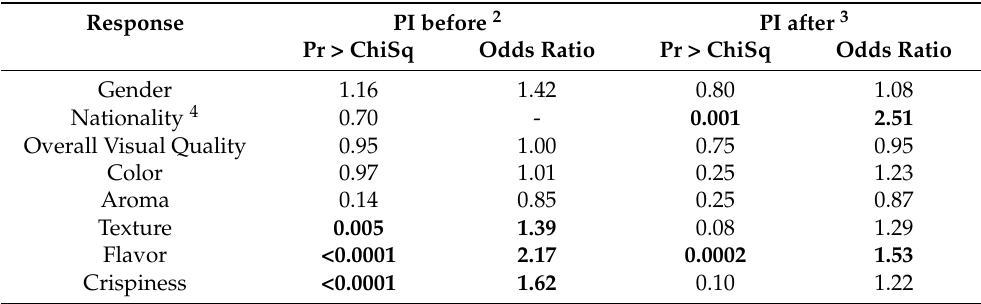
Table 5. Odds ratio estimates 1 for predicting purchase intent (PI) based on logistic regression